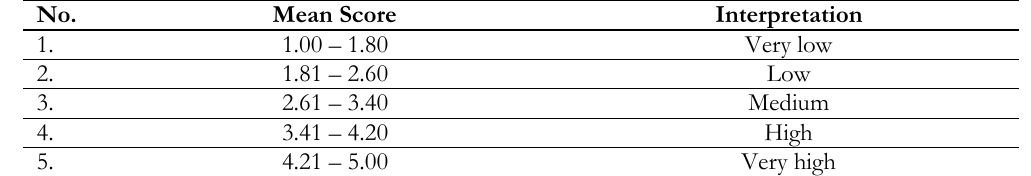
TABLE 2. Interpretation of mean score